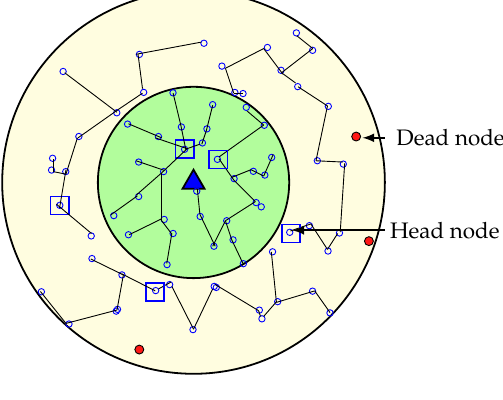
Figure 13. When all wedges merge.